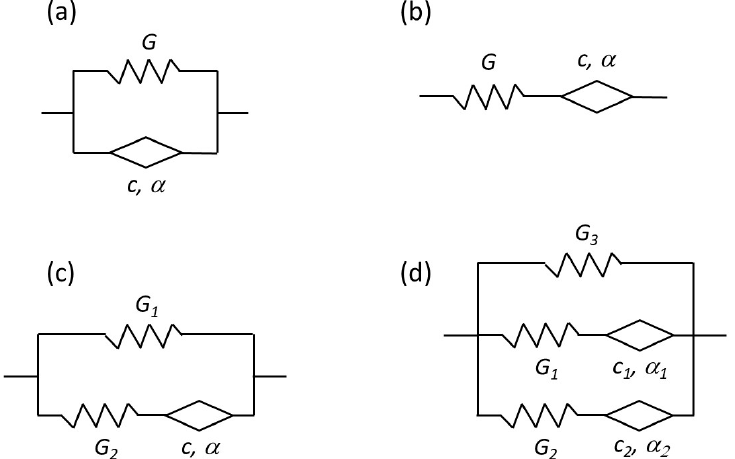
Figure 10. Fractional rheological models: ( a ) Kelvin–Voigt model; ( b ) Maxwell model; ( c ) Zener model; ( d ) generalized Maxwell model with two branches. G , G 1 , G 2 are the shear moduli of corresponding springs; c , c 1 , c 2 are viscoelasticity coefficients of the fractional elements; α , α 1 , α 2 are the order parameters of the fractional elements.